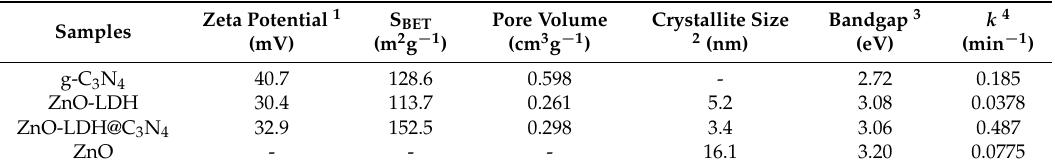
Table 1. Zeta potential, BET surface area, pore volume, crystallite size and bandgap for the samples and the pseudo-first-order rate constant for MB photocatalytic degradation over different photocatalysts.